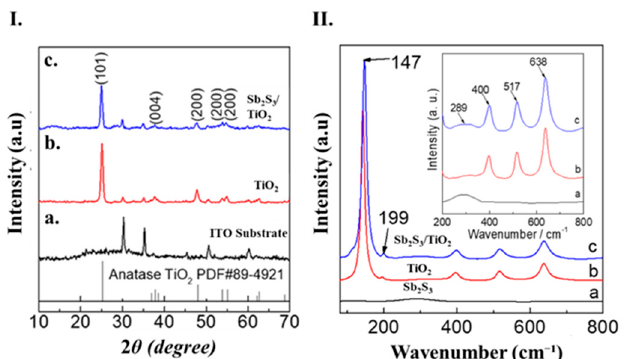
Figure 2. ( I ) X-RD data; ( a ) ITO substrate; ( b ) TiO 2 , and ( c ) Sb 2 S 3 /TiO 2 photo-anodes, respectively; ( II ) Raman spectroscopy; ( a ) Sb 2 S 3 , ( b ) TiO 2 , and ( c ) Sb 2 S 3 /TiO 2 powders, respectively.